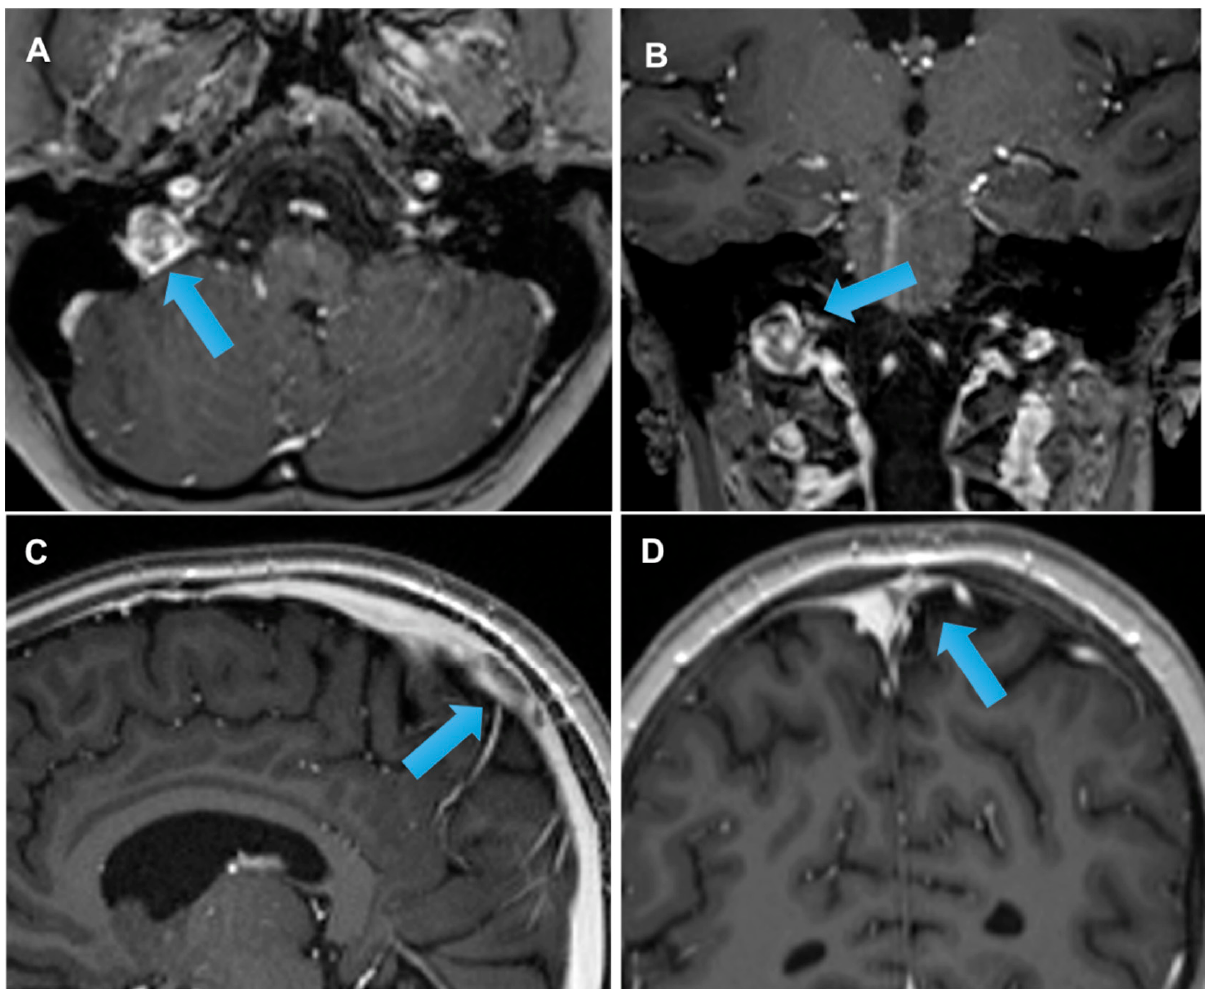
Figure 4. Patient affected by Hodgkin lymphoma during treatment. T1 w MRI after gadolinium administration demonstrates the presence of a complete venous thrombosis of the right jugular vein (arrow, A and B ) and a non-complete thrombus into the superior sagittal sinus on the T1 sagittal view (arrow, C ) and coronal view (arrow, D ).